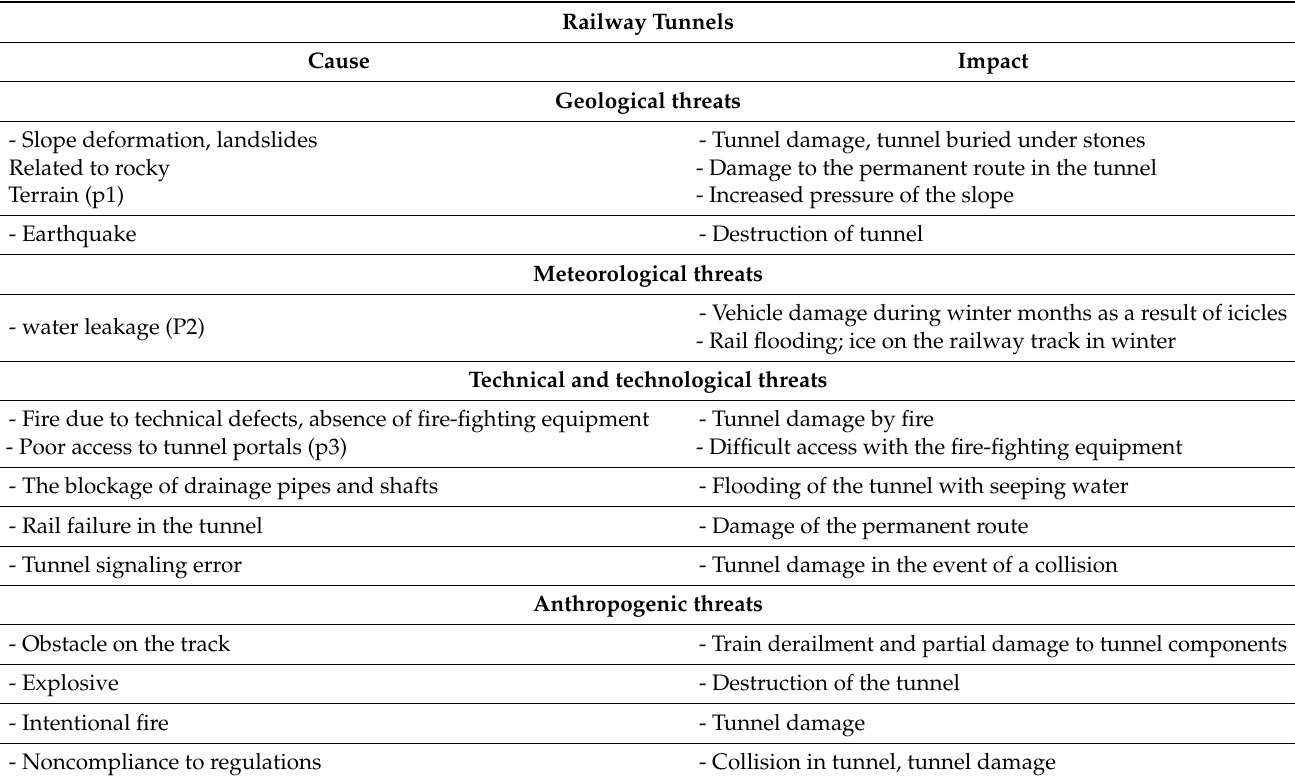
Table 1. Threats related to